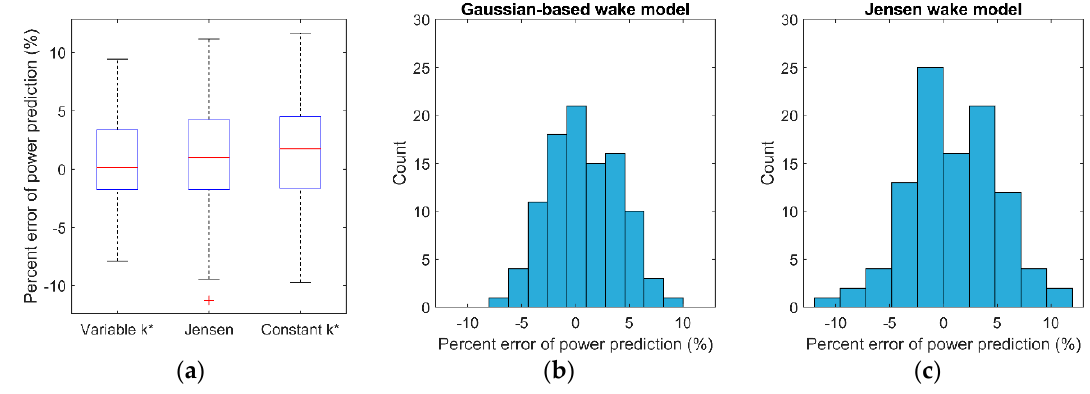
Figure 13. Comparison of sitewide total power prediction from 100 selected cases: ( a ) boxplot of percent error of power prediction using three different methods; ( b ) histogram of percent error of power prediction using the Gaussian-based model with variable k ∗ ; and ( c ) histogram of percent error of power prediction using the Jensen model.